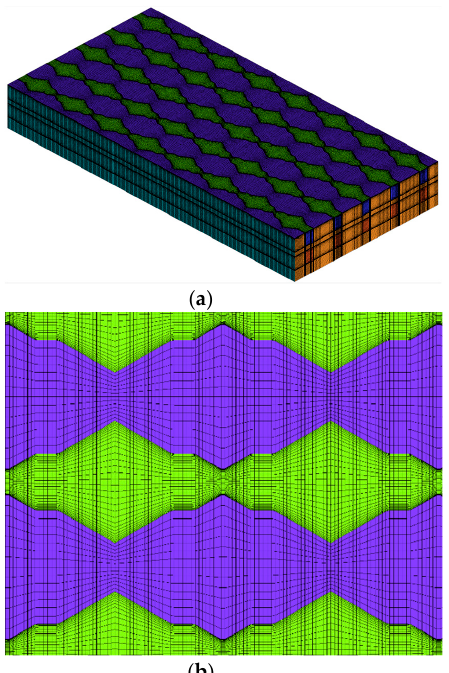
Figure 3. ( a ) Global mesh and ( b ) detail mesh of DL-T.